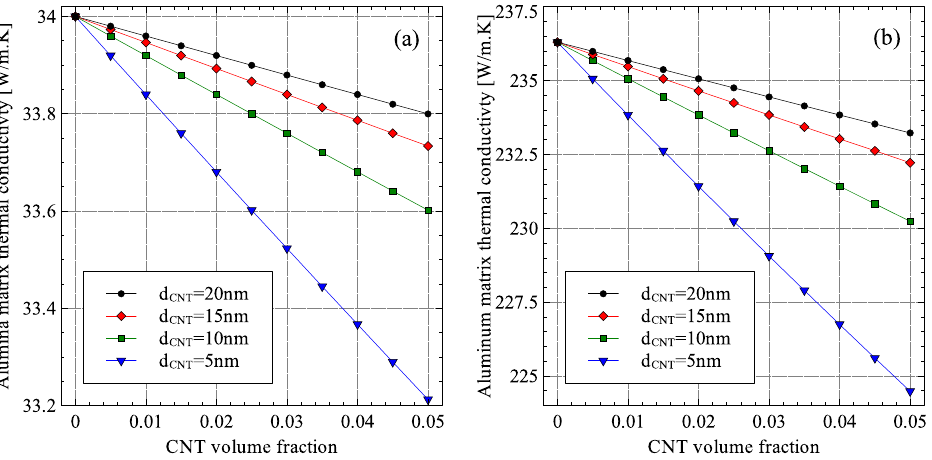
Figure 14. Modified ( a ) alumina matrix and ( b ) aluminum matrix thermal conductivities in MWCNT nanocomposites with randomly oriented CNTs.